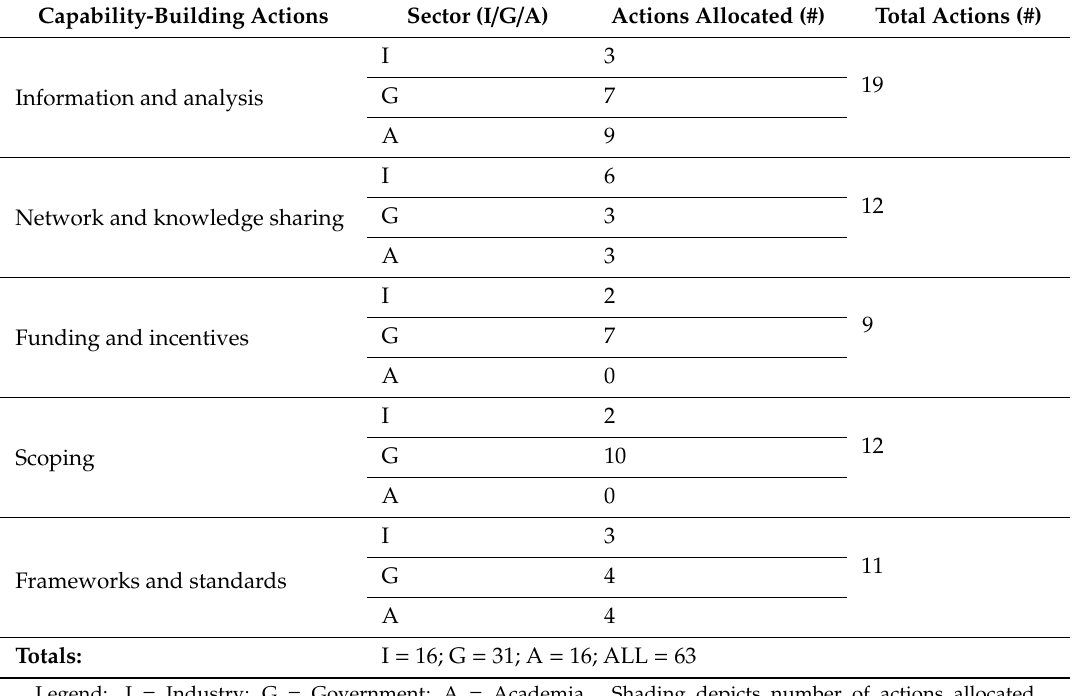
Table 2. Coding of priority capability-building actions against emergent themes and